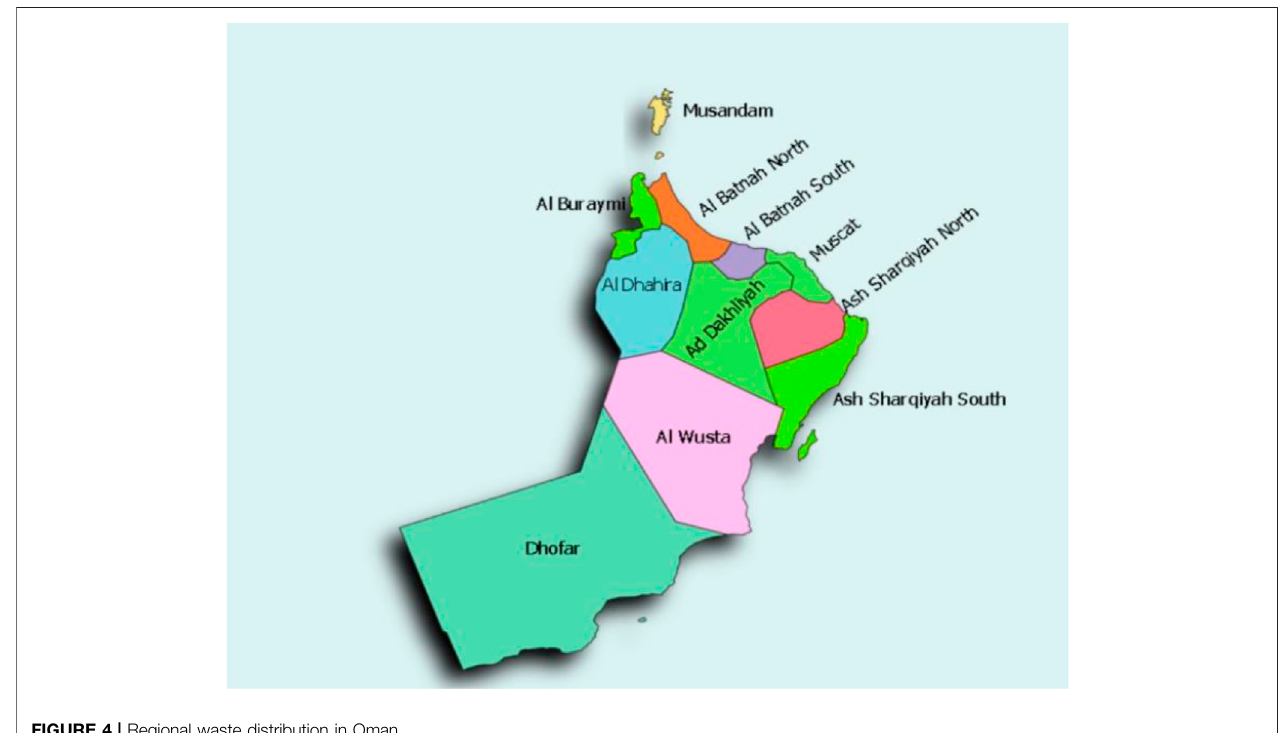
FIGURE 4 | Regional waste distribution in Oman.